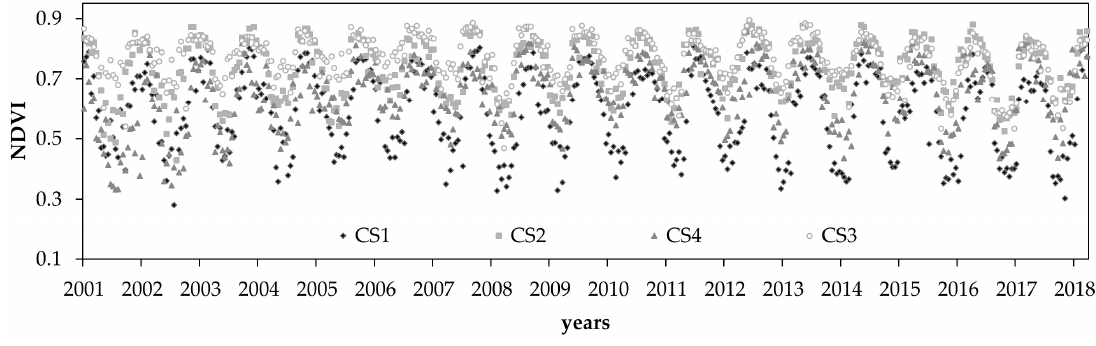
Figure 5. Normalized Difference Vegetation Index (NDVI) temporal pattern observed at CS1–CS4 during the 2011–2018 period.